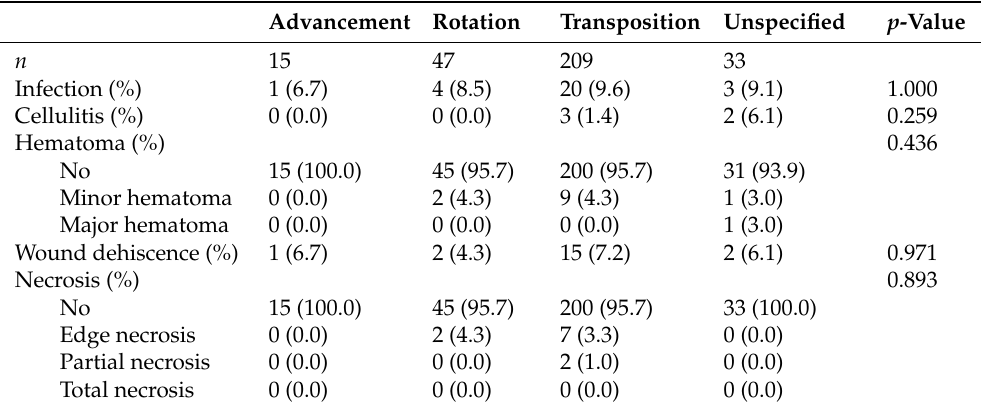
Table 5. Complications related to principle flap design.